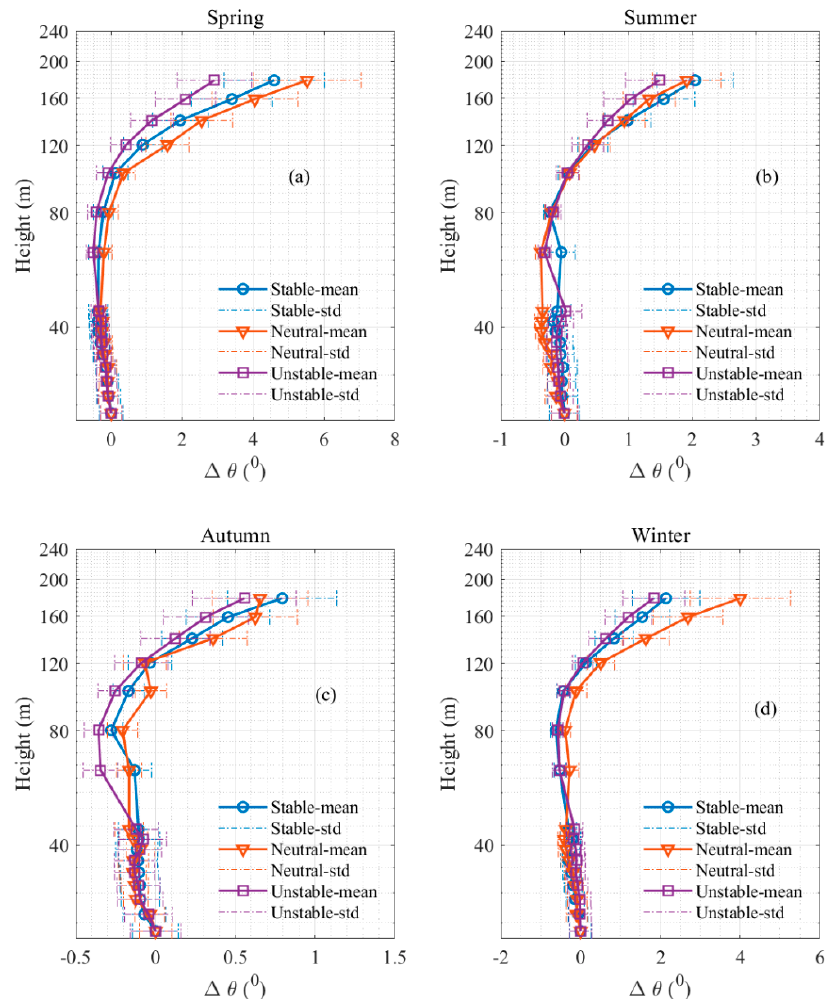
Figure 7. Composite wind veer profiles as a function of seasonality. ( a ) spring ( b ) summer ( c ) autumn ( d ) winter.